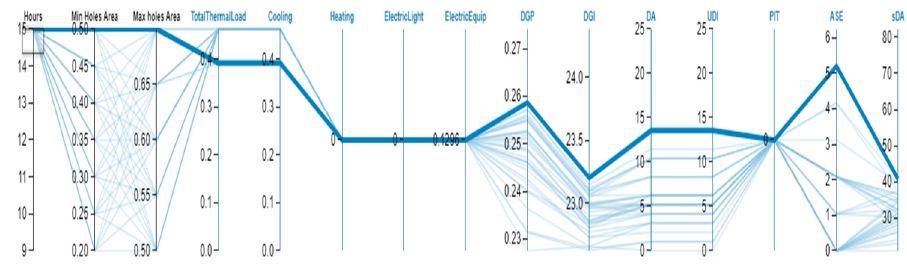
Figure 22. Choosing the optimal condition for different hours on 22nd September. Table 6. Best values for the opening ratio of shading device on 22nd September. The Maximum Ratio of Opening